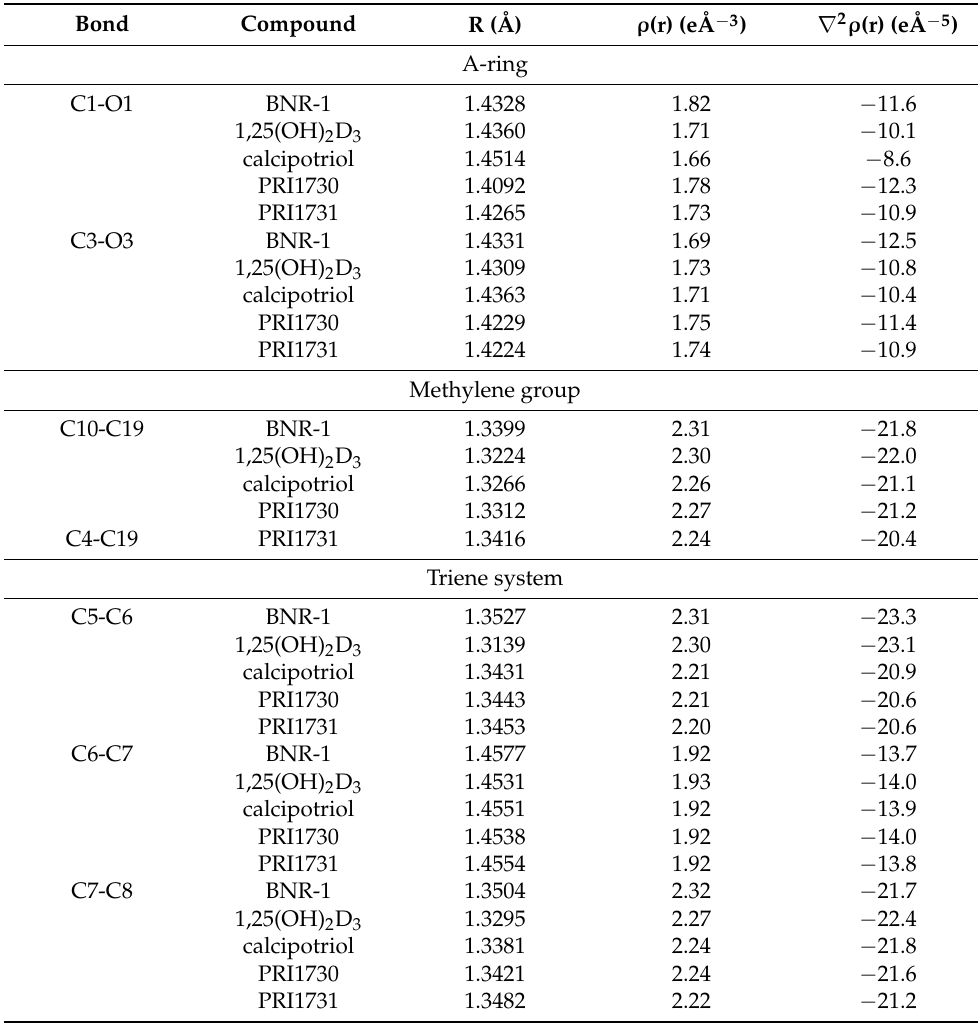
Figure 5. Deformation density maps for BNR-1, Syn-1G, PRI-1730 and PRI-1731. Maps are presented with contour levels with intervals of ±0.05 eÅ − 3 . Maps were prepared for planes determined by C-15 (center), C-14 (x axis) and C-16 (y axis) atoms. Table 2. Selected topological properties of analysed bonds and intermolecular interactions for vitamin D analogues and